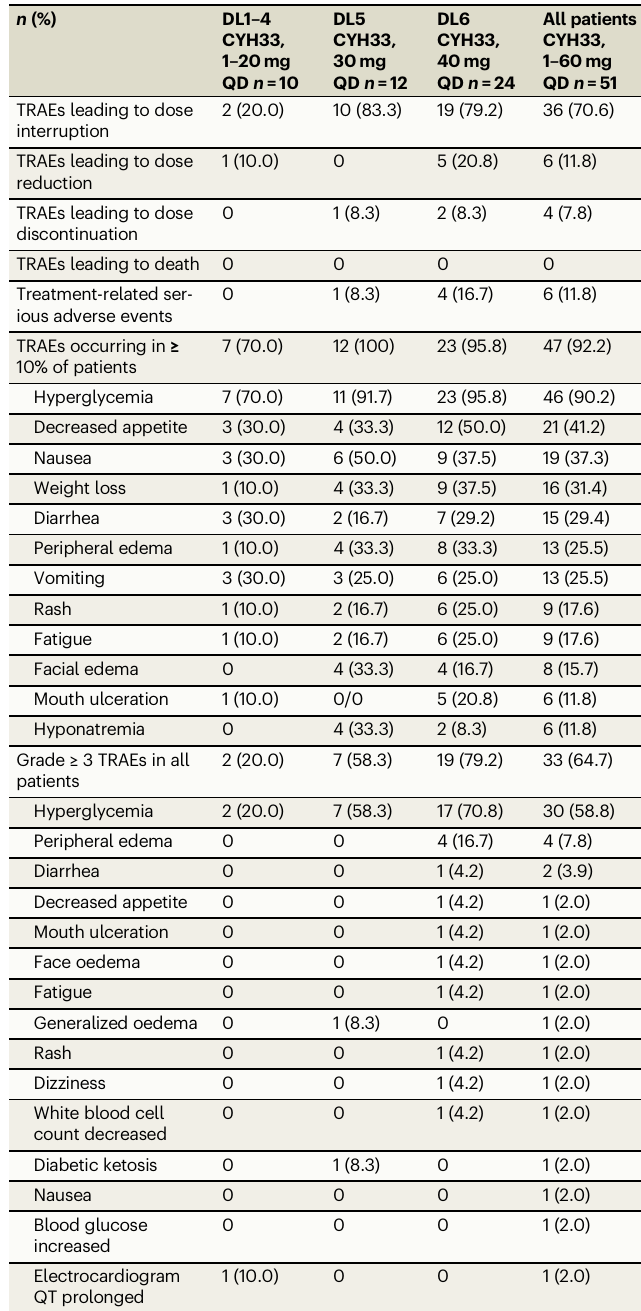
Table 2 | Summary of treatment-related adverse events n